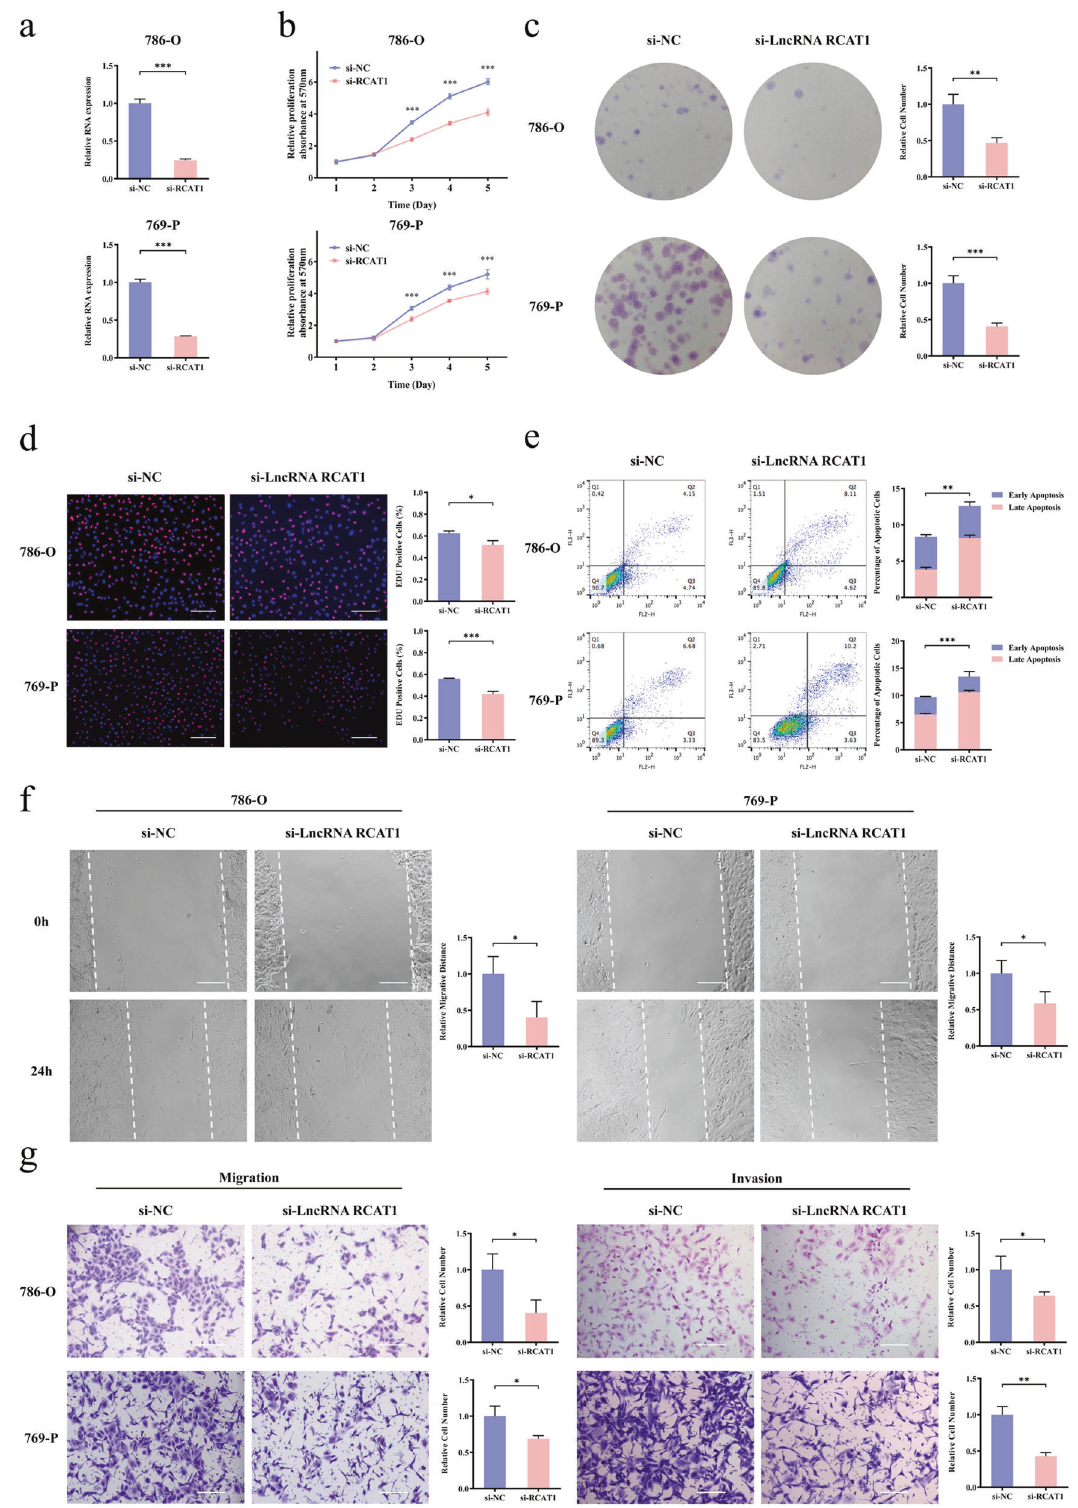
Fig. 4 lncRNA RCAT1 knockdown suppresses malignant phenotypes in RCC cells. a The lncRNA RCAT1 mRNA levels in 786-O and 769-P cells transfected with lncRNA RCAT1 or negative control siRNAs. b The cell proliferation of 786-O and 769-P cells in response to lncRNA RCAT1 knockdown was measured using MTT assay. c Colony-formation assays performed with the 786-O and 769-P cells transfected with lncRNA RCAT1 or negative control siRNAs. d EdU assay was used to evaluate the effect of lncRNA RCAT1 knockdown on cell proliferation. Scale bar, 200 μ m. e Apoptosis was assayed by fl ow cytometry in 786-O and 769-P cells after lncRNA RCAT1 knockdown. f The wound-healing assay was performed to examine the migration abilities after lncRNA RCAT1 knockdown. Scale bar, 200 μ m. g The effects of lncRNA RCAT1 knockdown on migration and invasive abilities of 786-O and 769-P cells were evaluated by the transwell assays. Scale bar, 200 μ m ( * P < 0.05, ** P < 0.01, *** P < 0.001). Cell Death and Disease (2021)